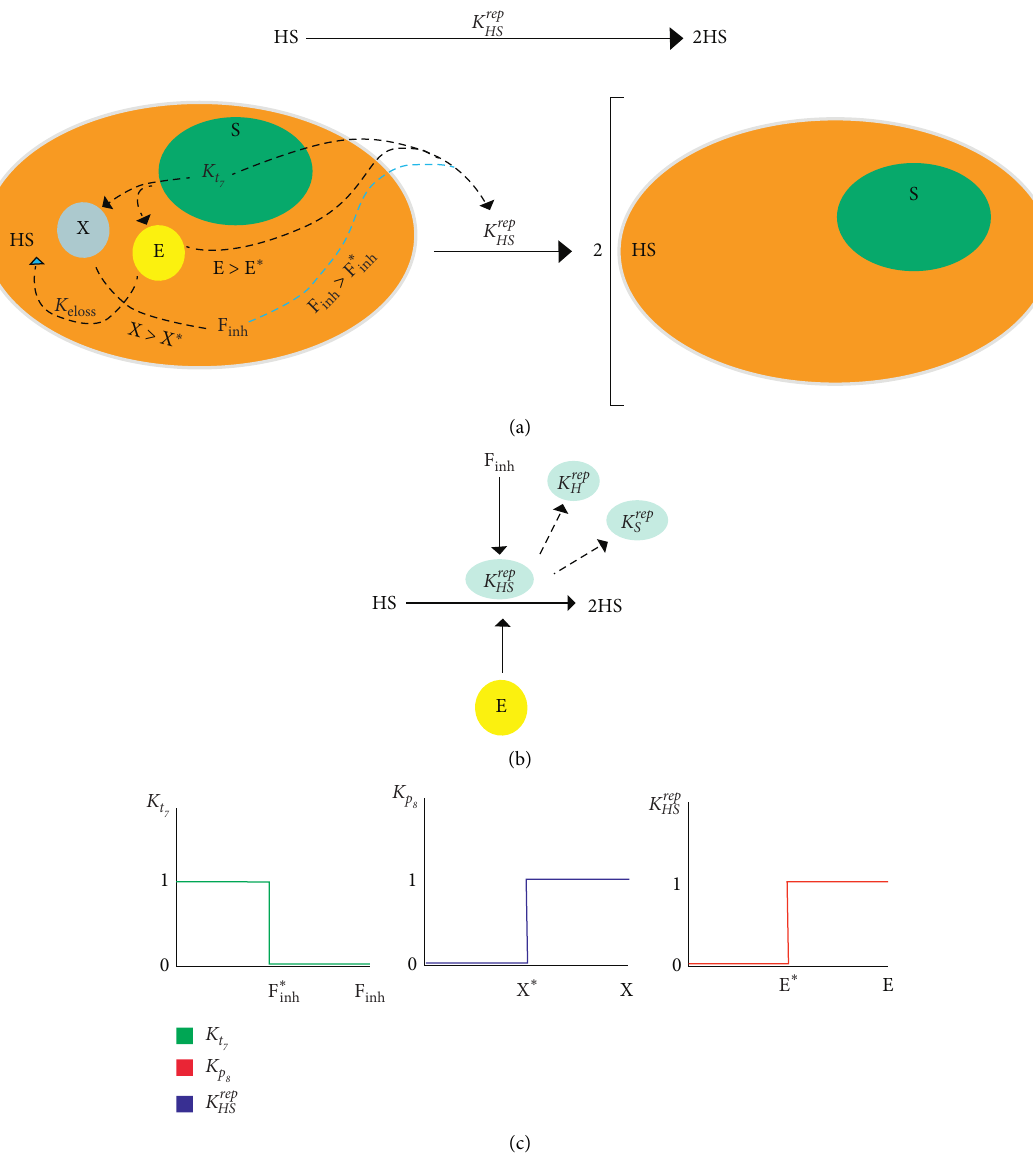
Figure 3: Schema of the regulation of species through two levels of interaction. (a) Representation of the interaction between the host ( H in orange) and the Symbiodinium ( S in green) in the reaction r p ways of regulation of k rep , occurring when E > E ∗ , x > x ∗ , and F HS , by F and E , showing the indirect regulation of k rep S and k rep H in dotted lines. (c) Dependency of k t cells. (b) Regulation of k rep inh HS on F , x , and E , inh